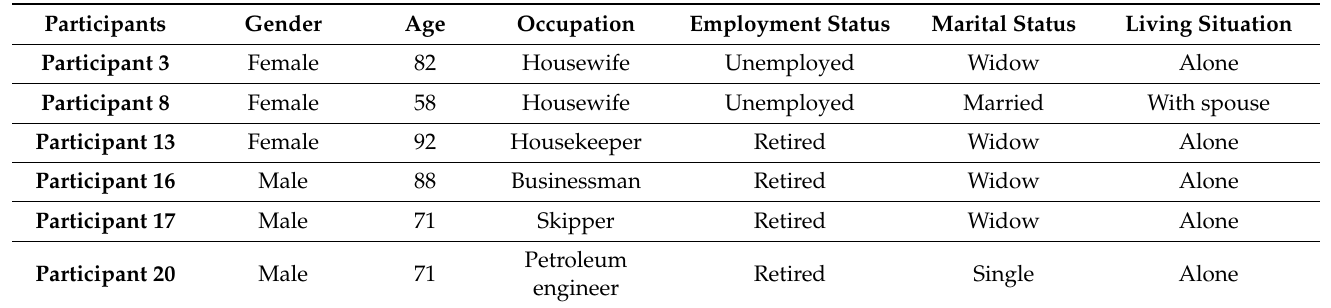
Table 2. Description of participant characteristics from in-depth individual